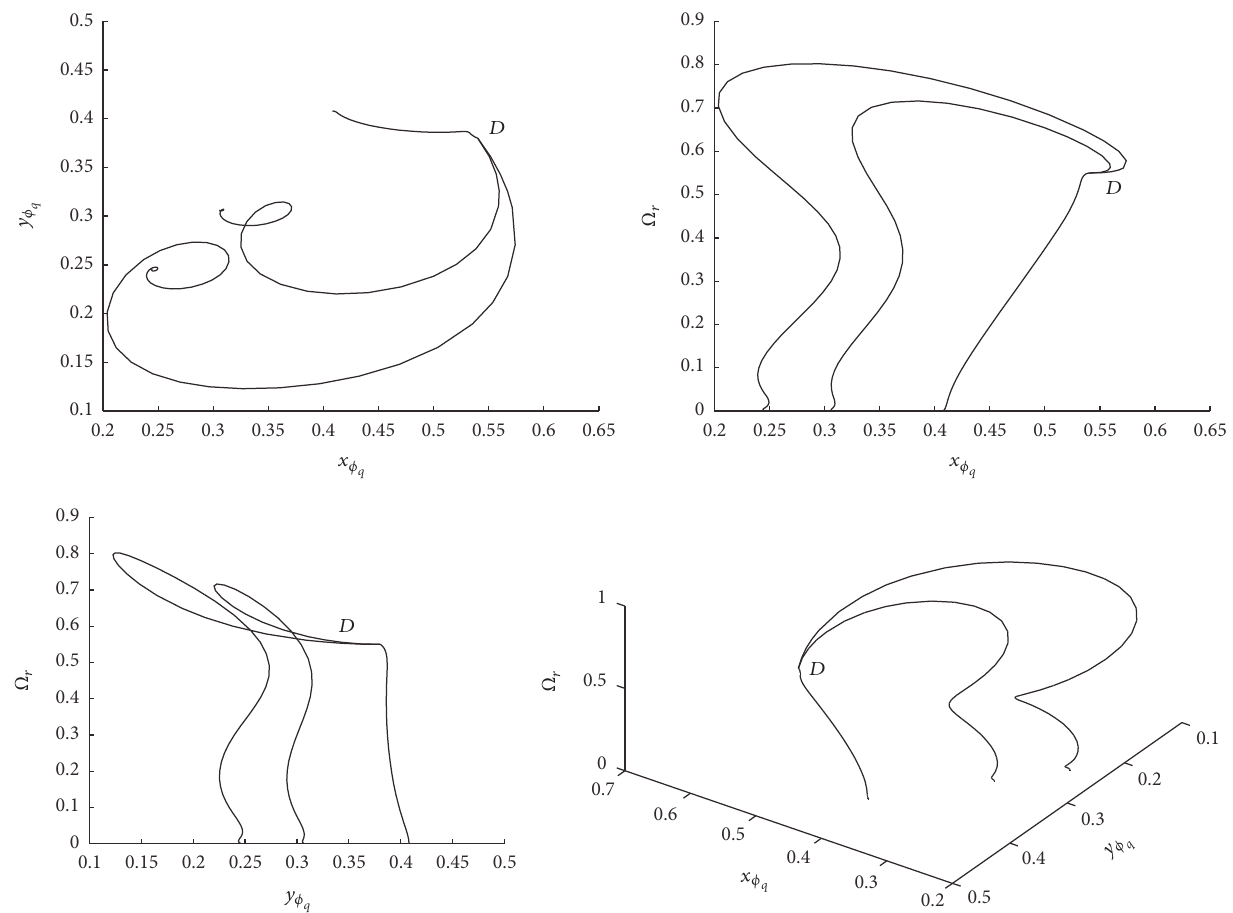
Figure 4: Two- and three-dimensional projections of the phase-space trajectories for 𝛽 = 1.5 , 𝜆 = 3 , 𝜆 = 4 , and 𝜆 = 6 . All plots begin from the critical point 𝐷 = (0.54, 0.38,0, 0.55) being an unstable